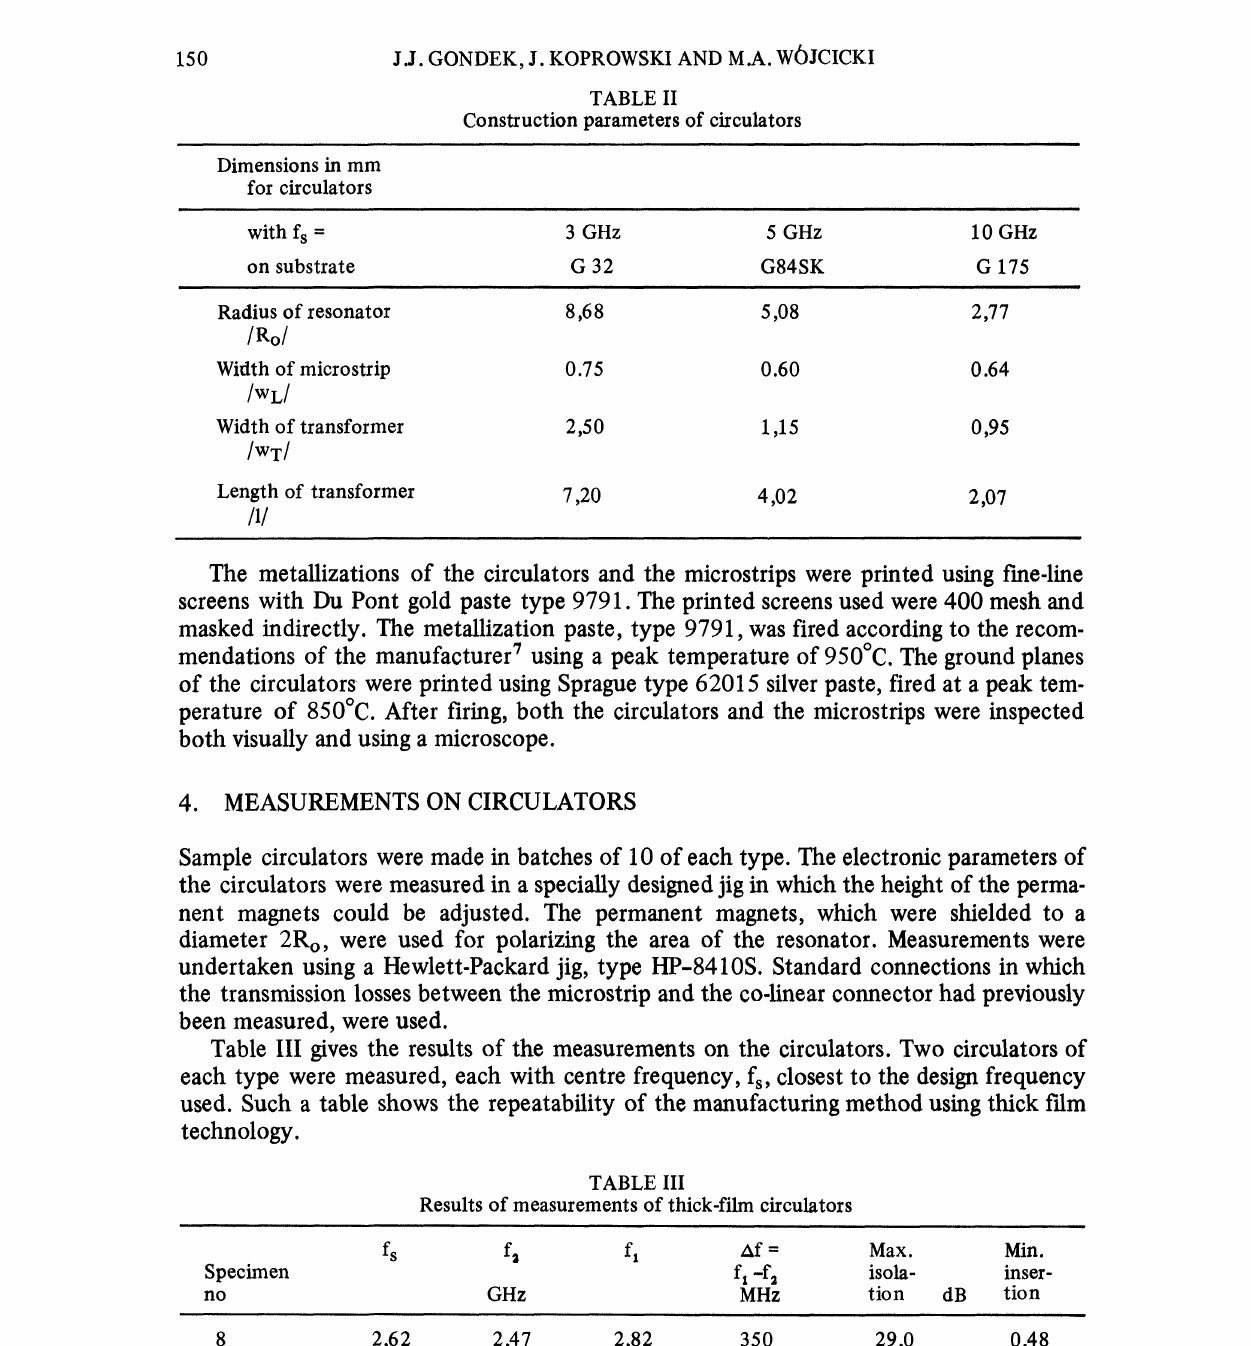
TABLE II Construction parameters of circulators